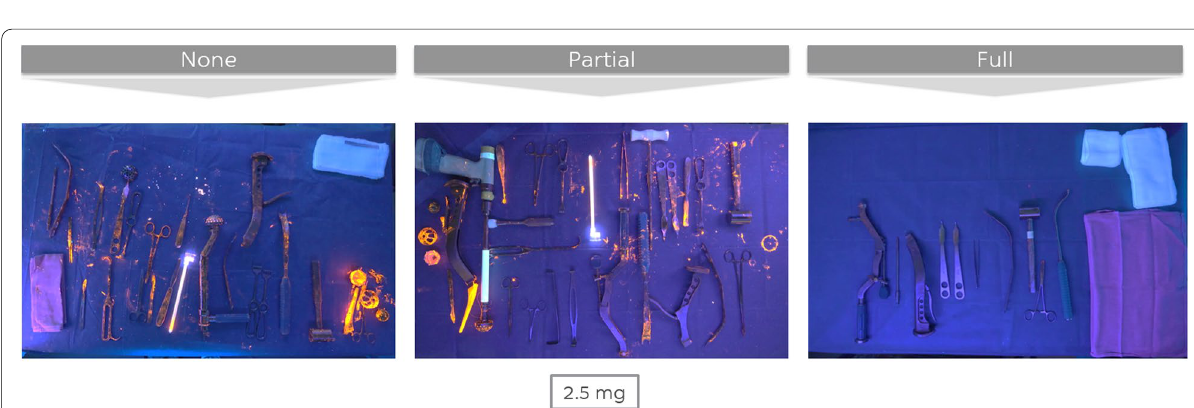
Fig. 5 Remaining instrument table at the end of the one-step exchange for three different clean phase protocols (bacterial load 3 GloGerm